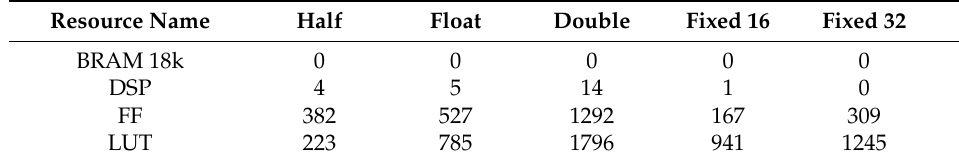
Table 4. Resource utilization of different data format